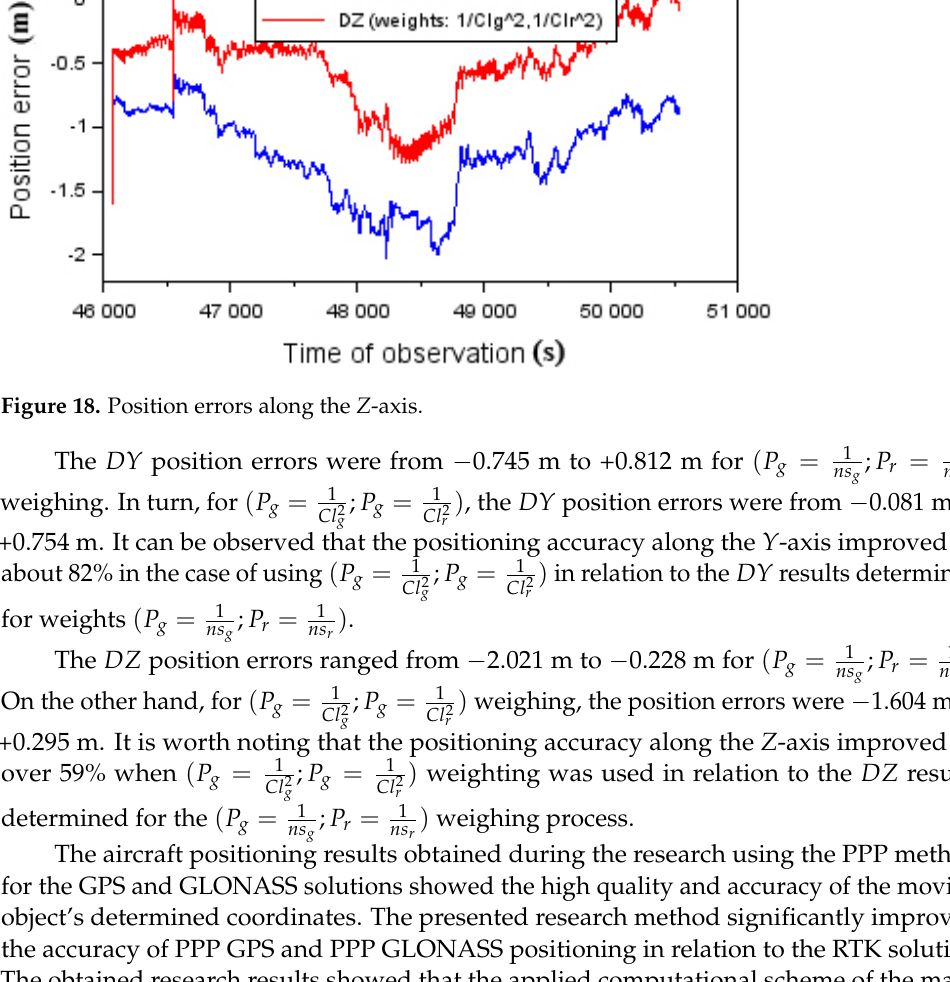
Figure 17. Position errors along the Y -axis.